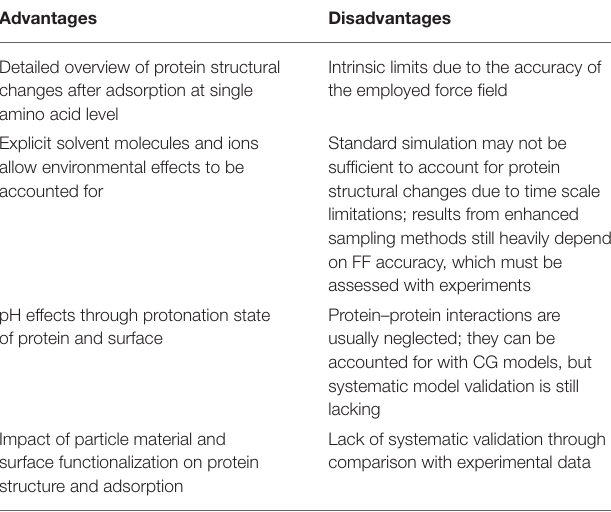
TABLE 1 | Advantages and disadvantages in protein–surface simulation. Advantages Disadvantages Detailed overview of protein structural changes after adsorption at single amino acid level